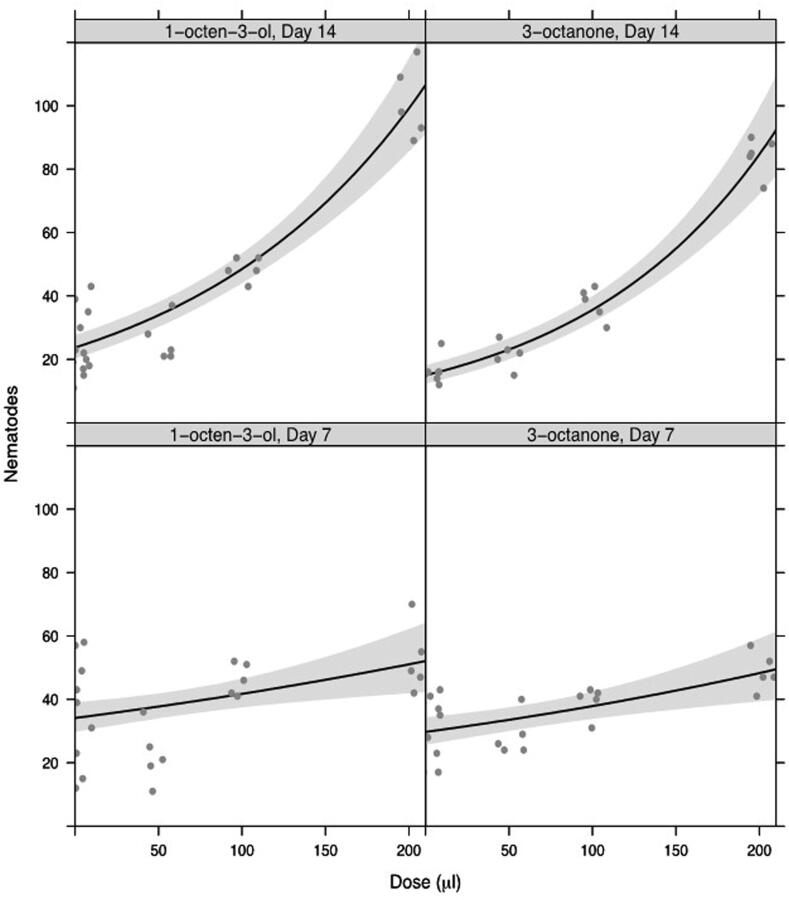
Dose-response curves for behavioural responses of M. hapla following treatment with VOCs, and assessed 7 and 14 days post treatment. Fitted lines show log-linear responses. Shaded ribbons show 95% confidence envelopes.